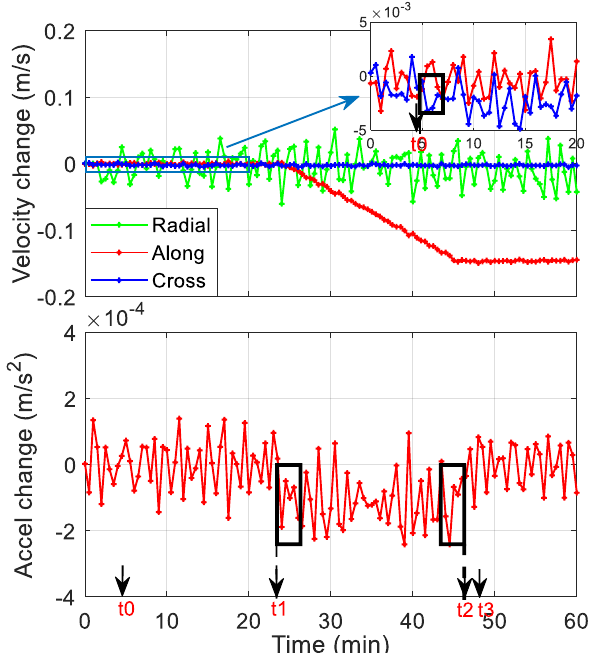
Figure 2. Thrust-induced velocity and acceleration changes of C03 during 09:05:30–10:05:30 on 23 October 2017.